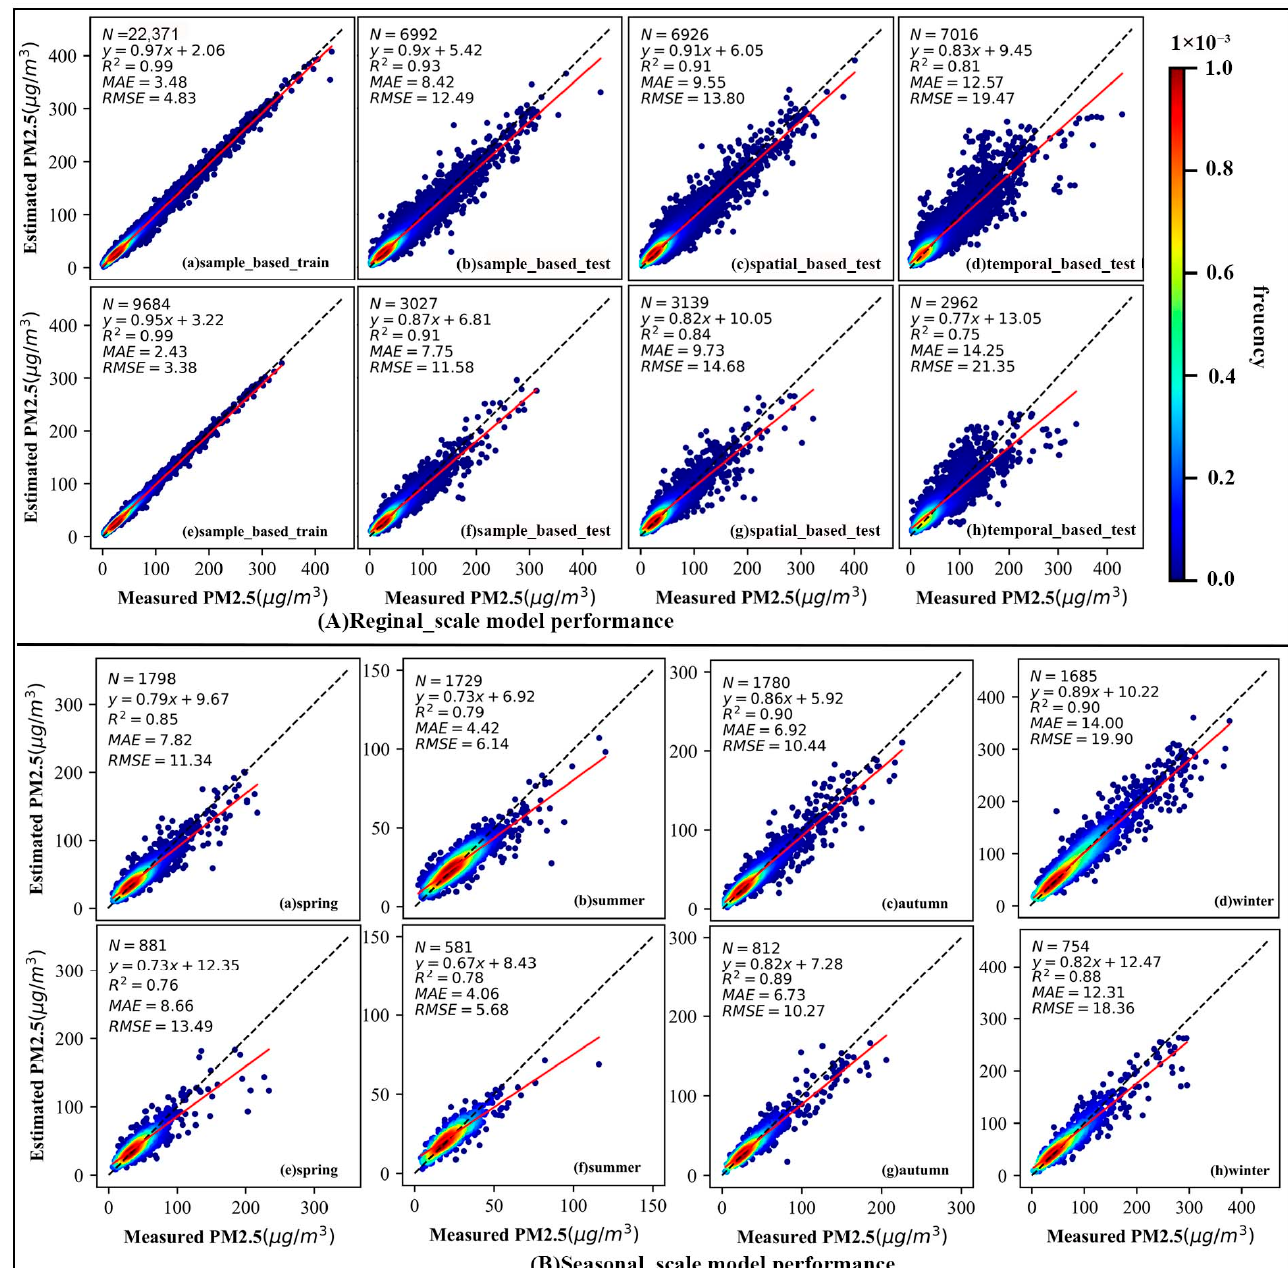
Figure 6. Density scatterplots of regional-scale model ( A ) with sample_based train, sample_based test, spatial_based test and temporal_based test examination results for DFM ( a – c ) and DFC ( d – f ) at daily scale, and seasonal scale ( B ) with DFM (top row) and DFC (bottom row) based sample_based test for sprint ( a , e ), summer ( b , f ), autumn ( c , g ) and winter ( d , h ) in GUA. The black dash and solid red lines represent the 1:1 and linear regression lines, respectively.